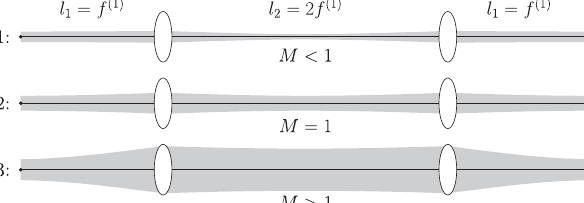
FIG. 3. Gaussian beam profiles for self-consistent solutions in the symmetric confocal cavity, shown for different initial Ray- leigh range values Z o ¼ f ð 1 Þ =M . The second Gaussian beam waist is in the midpoint of the round-trip path, with the size of the beam waist (relative to the original waist size) scaling with the magnification factor M